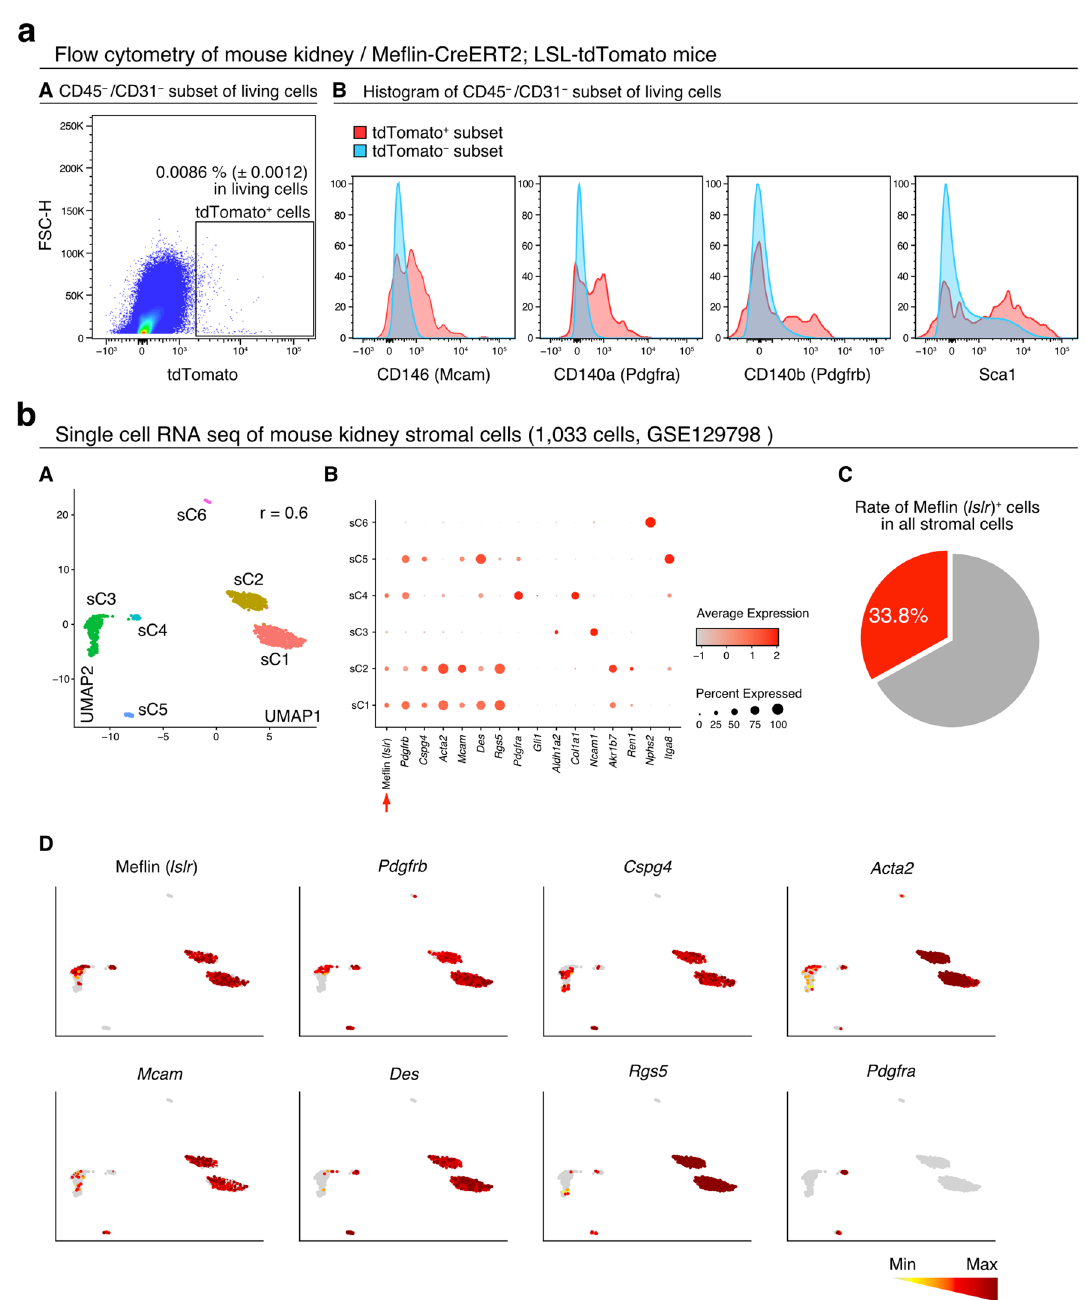
Figure 2. Expression of Meflin in cells positive for conventional pericyte or PMC markers. ( a ) Flow cytometry of cells isolated from the kidneys of adult Meflin-CreER T2 ; LSL-tdTomato mice administered TAM ( n = 3); 0.0086 ± 0.0012% of CD45 − /CD31 − living cells were positive for tdTomato ( A ). Histogram of tdTomato + (red) and tdTomato − (blue) subsets stained with typical pericyte markers, including CD146 (Mcam), CD140a (Pdgfrα), CD140b (Pdgfrβ), and Sca1 ( B ). ( b ) UMAP plots showing distinct stromal cell populations (sC1–6) identified by single-cell RNA-seq of all stromal cells isolated from the mouse kidney (GEO accession number GSE129798) ( A ). r indicates the clustering resolution. Meflin ( Islr ) mRNA (indicated with an arrow) was expressed in the stromal cell subsets sC1, sC2, and sC4, overlapping with other stromal cell markers to varying degrees ( B ). Meflin was expressed in 33.8% of all stromal cells ( C ). Feature plots showing the expression of Meflin and other pericyte and PMC markers in the stromal cell subsets ( D ). Data were analyzed and visualized using R software 47